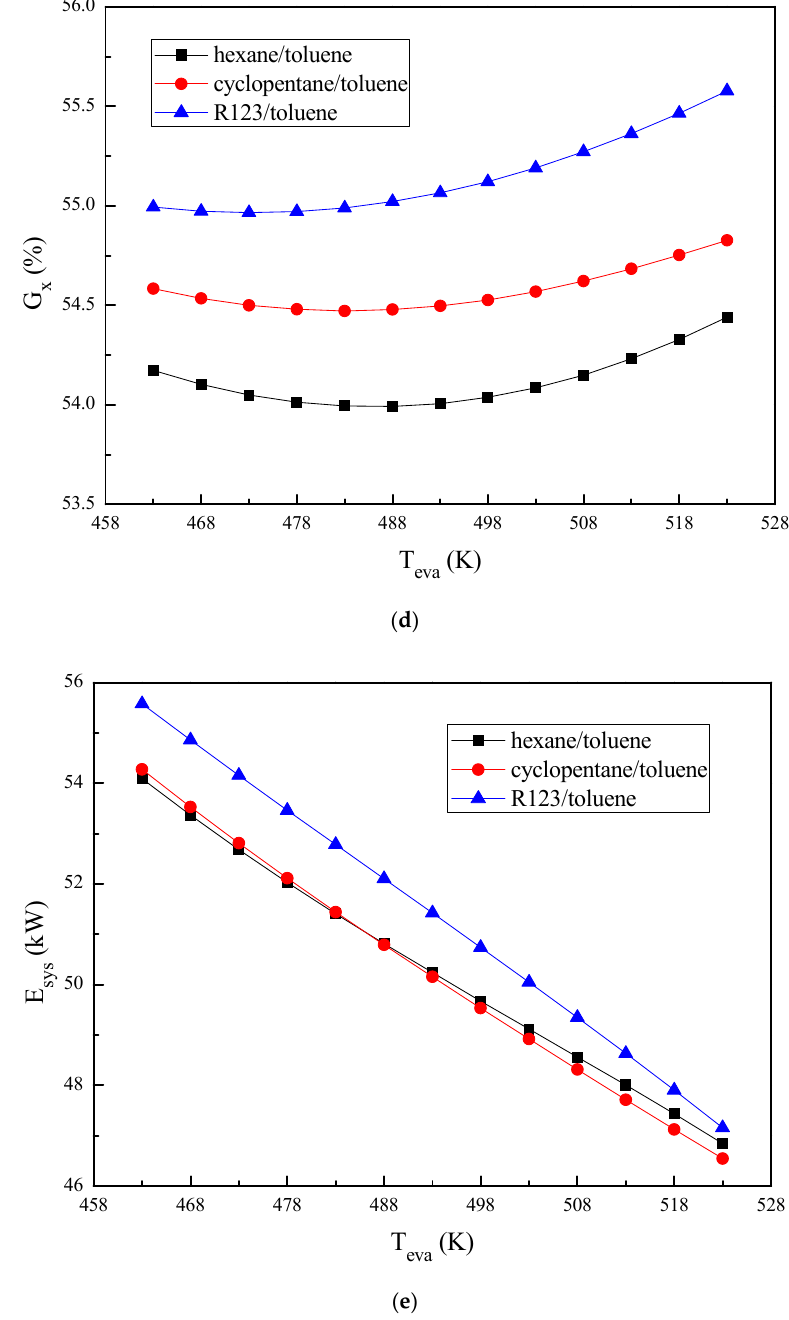
Figure 3. Effects of the high-temperature (HT) loop evaporation temperature on system performance: ( a ) Variation of net power output; ( b ) variation of entropy generation rate; ( c ) variation of entransy loss rate; ( d ) variation of entransy efficiency; ( e ) variation of exergy loss.